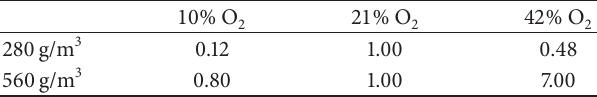
Table 1: Summary of the normalized Damk¨ohler numbers. Table 2: Flame speed scaling in the diffusion limit.